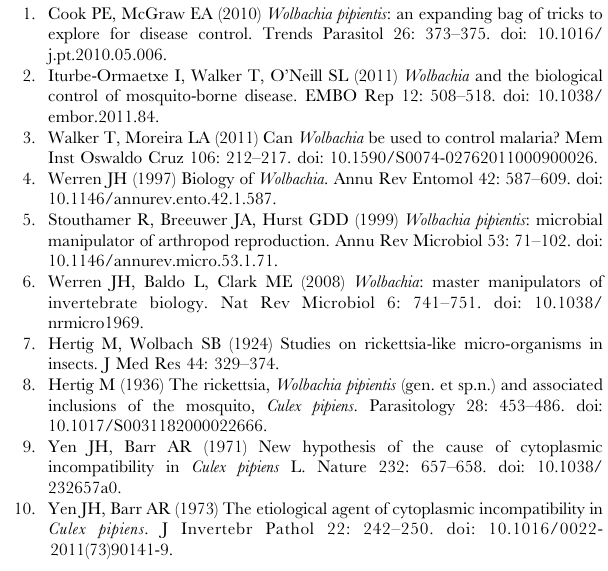
Figure S1 Age-related changes in the density of w Flu in male Ae. fluviatilis . Graphs showing the absolute (A) and relative (B) densities of w Flu in males of the wildtype strain ( wolb + ) of the mosquito Ae. fluviatilis